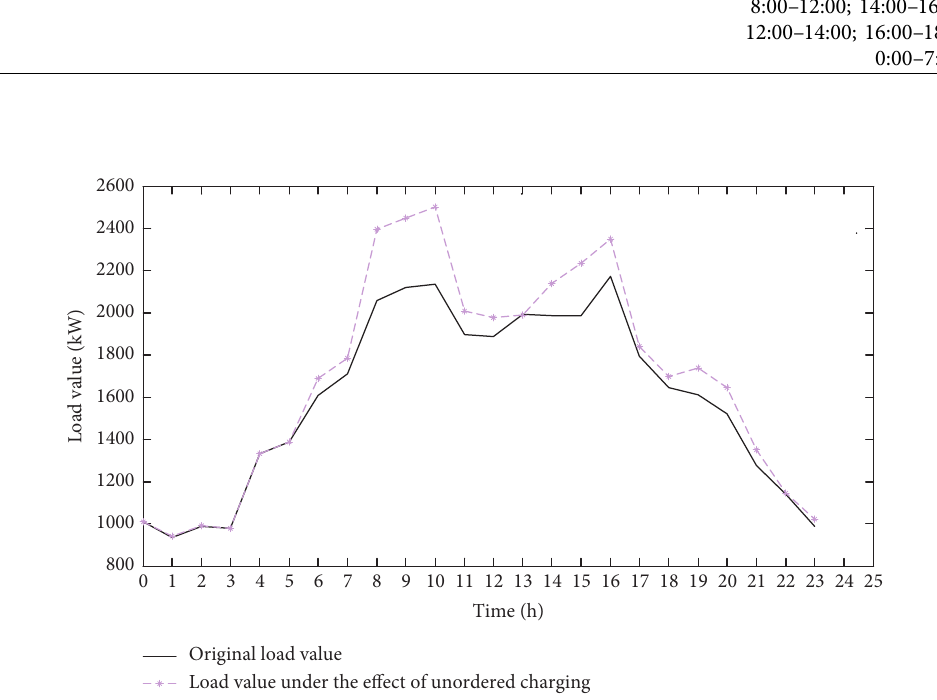
Figure 8: Influence of disordered charging behavior on grid load.